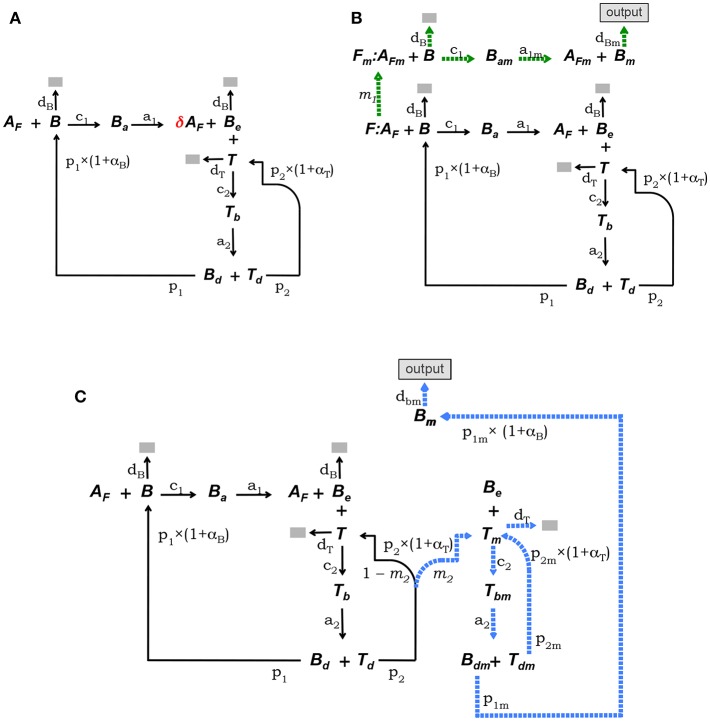
Diagrammatic representation of the three alternative models of the GC reaction. (A) Model 1, it assumes that Ag is consumed proportionally to the number of B cells binding Ag on FDCs. (B) Model 2, here FDCs are assumed to change from initial phenotype F to phenotype Fm due to interactions with Ag-specific B cells. B cells interacting with Ag on Fm cells (i.e., AFm) differentiate into plasma or memory B cells (Bm), which exit the GC (indicated by the label “output”). (C) Model 3, here it is assumed that Tfh cells change phenotype, so that B cells interacting with those mature Tfh cells differentiate into plasma or memory B cells (Bm), exiting the GC (“output”). In both models, 2 and 3, Ag consumption by B cells is assumed not to lead to significant Ag depletion.